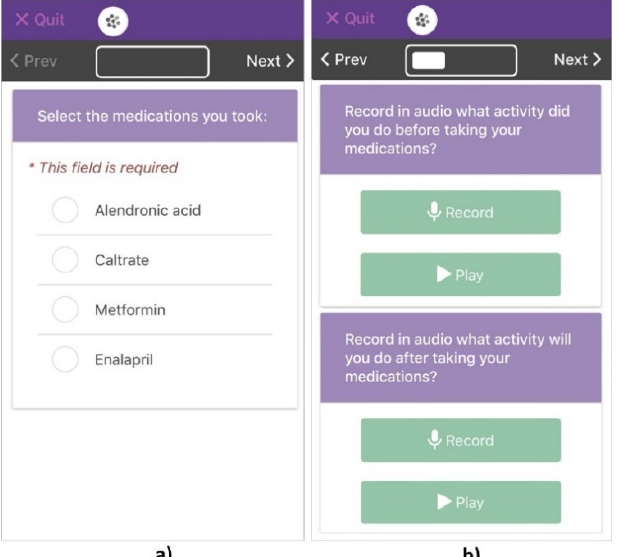
Figure 1. The tablet-based system implemented with EpiCollect5 [37] presents: ( a ) the list of a par- ticipant’s medications to be checked if they were taken, and ( b ) the options to audio-record the ac- tivities conducted before and after the medication episode.